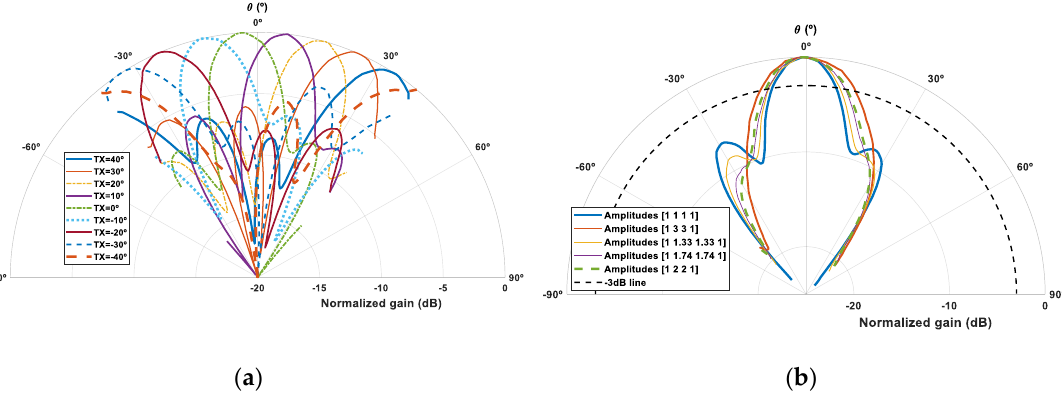
Figure 13. Measurement results: ( a ) polar plot of the measured radiation patterns; ( b ) measured antenna radiation pattern for many amplitude variations.